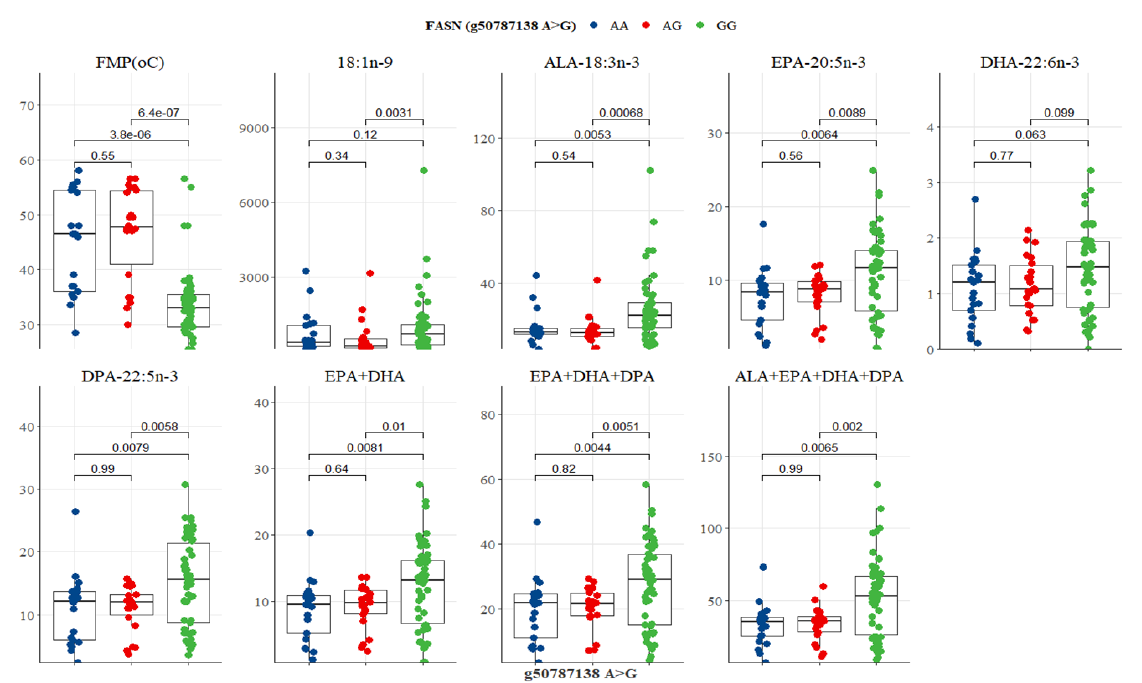
Figure 9. Tukey-adjusted multiple comparisons between a FASN SNP locus with FMP, IMF, and fatty acid profiles of Bowen Genetics Forest Pastoral Angus, Hereford, and Wagyu. Each box plot tested the median IMF, FMP, and fatty acid in AA versus AG, AA versus GG, and AG versus GG genotypes. Significant level set at ( p < 0.05).